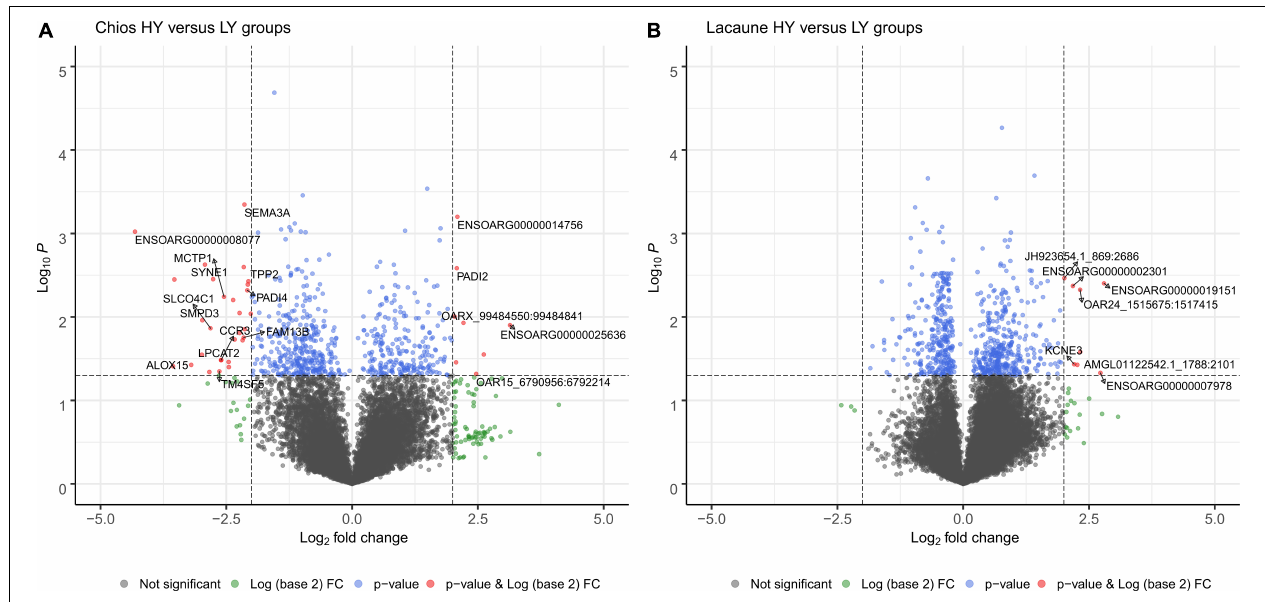
FIGURE 3 | Distribution of genes as a volcano plot according to level of significance for (A) Chios and (B) Lacaune breeds. Horizontal dashed lines signal the threshold for statistical significance, presented in log 10 scale (differentially expressed genes with p -value < 0.05). Values in x -axis represent the level of differentiation of genes (log 2 fc). Dashed vertical lines set the limits outside of which expression changes by fourfold; genes (marked in red) with log 2 fc < –2 and p -val < 0.05 represent genes that are upregulated in HY groups and genes with log 2 fc > 2 and p -val < 0.05 represent genes that are overexpressed in LY